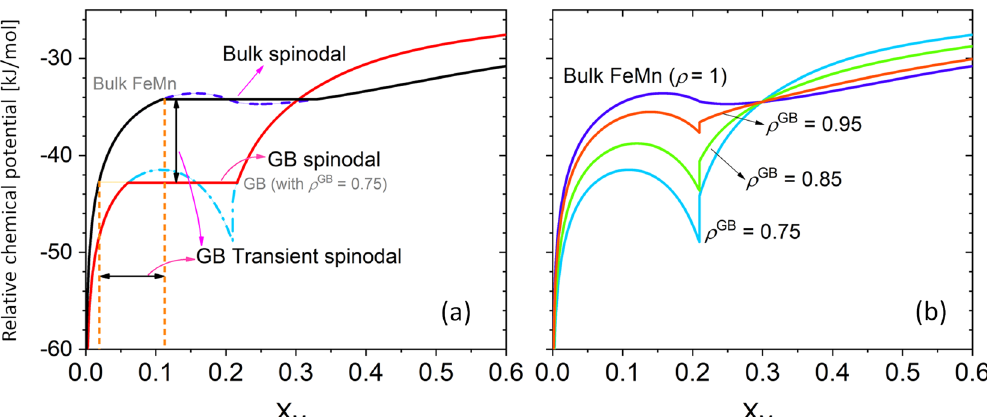
Fig. 8 Mn chemical potential for bulk and different GBs. a The equilibrium chemical potential curves for the bulk and a GB with average atomic density ρ GB = 0.75 at 450 °C are compared. The Maxwell construction is applied and the unstable sections of chemical potential curves are shown as dashed lines. Above the GB spinodal, segregation is accompanied with a transient spinodal phenomenon as discussed for the Fe – 9 at.% Mn alloy. The range of bulk compositions/chemical potentials for transient GB spinodal are marked with the two-sided black arrows. b The chemical potential curves for different GB density values (representing different GB types) are compared. Depending on the GB atomic density, the GB free energy density, the chemical potential and hence the coexistence of the bulk and GB can